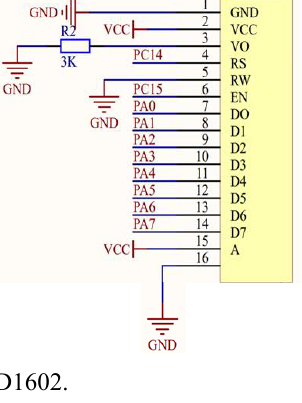
Fig. 6 . The circuit diagram of